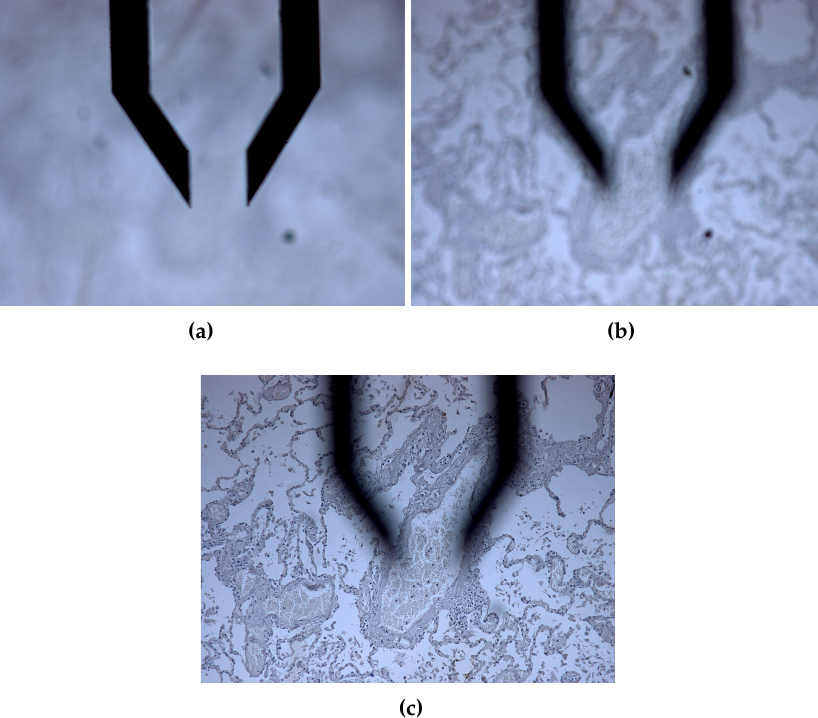
Figure 17. Lung tissue with gripper ( a – c ). ( a ) Lung (Focus a); ( b ) Lung (Focus b); ( c ) Lung (Focus